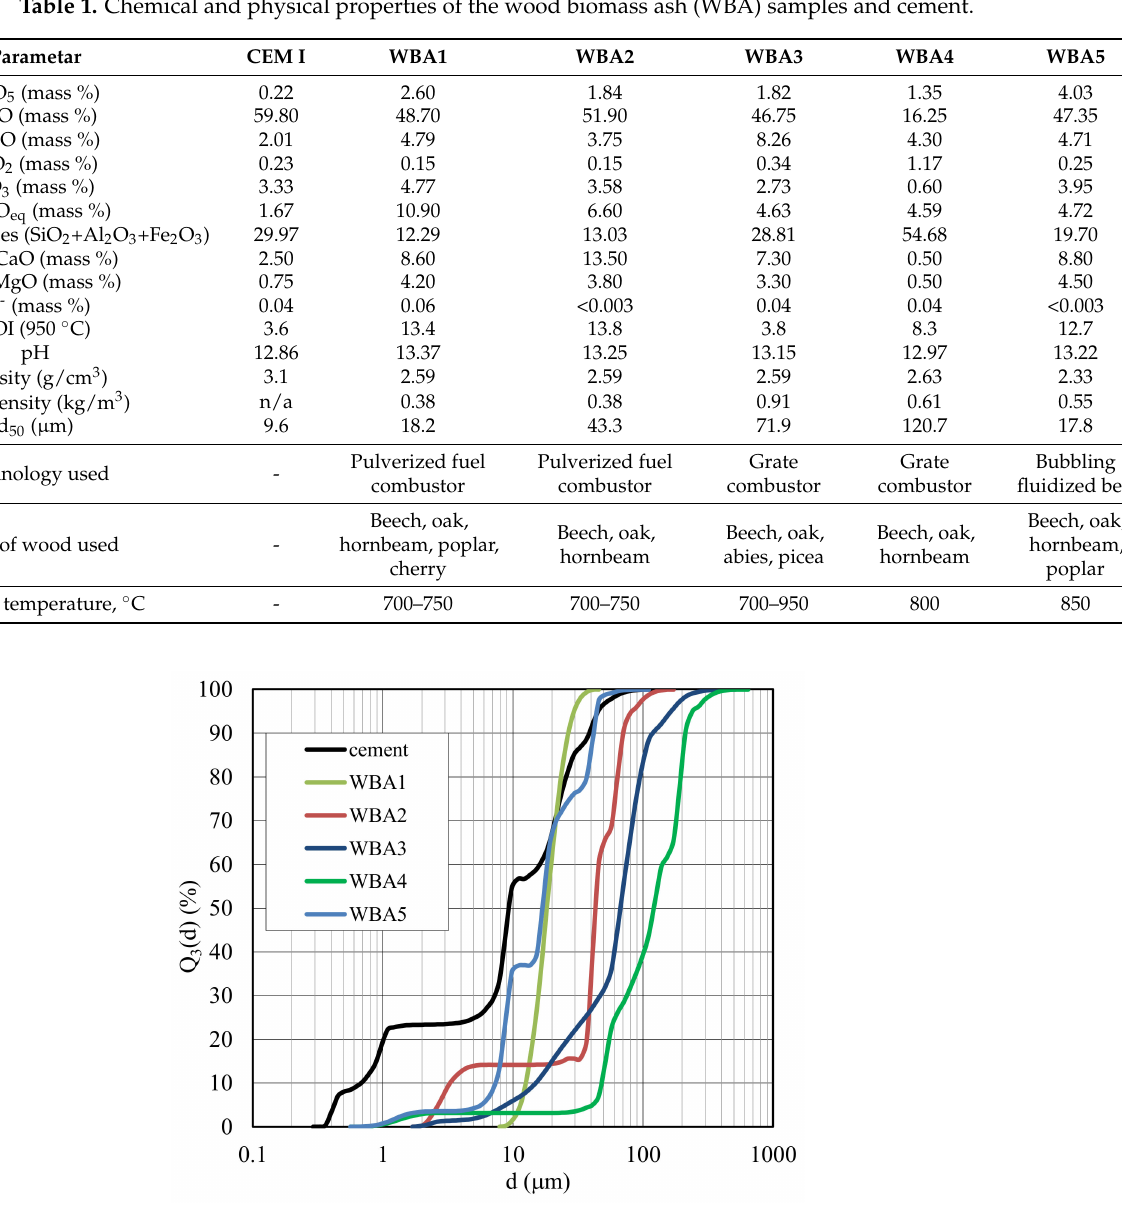
Figure 2. Particle size distribution